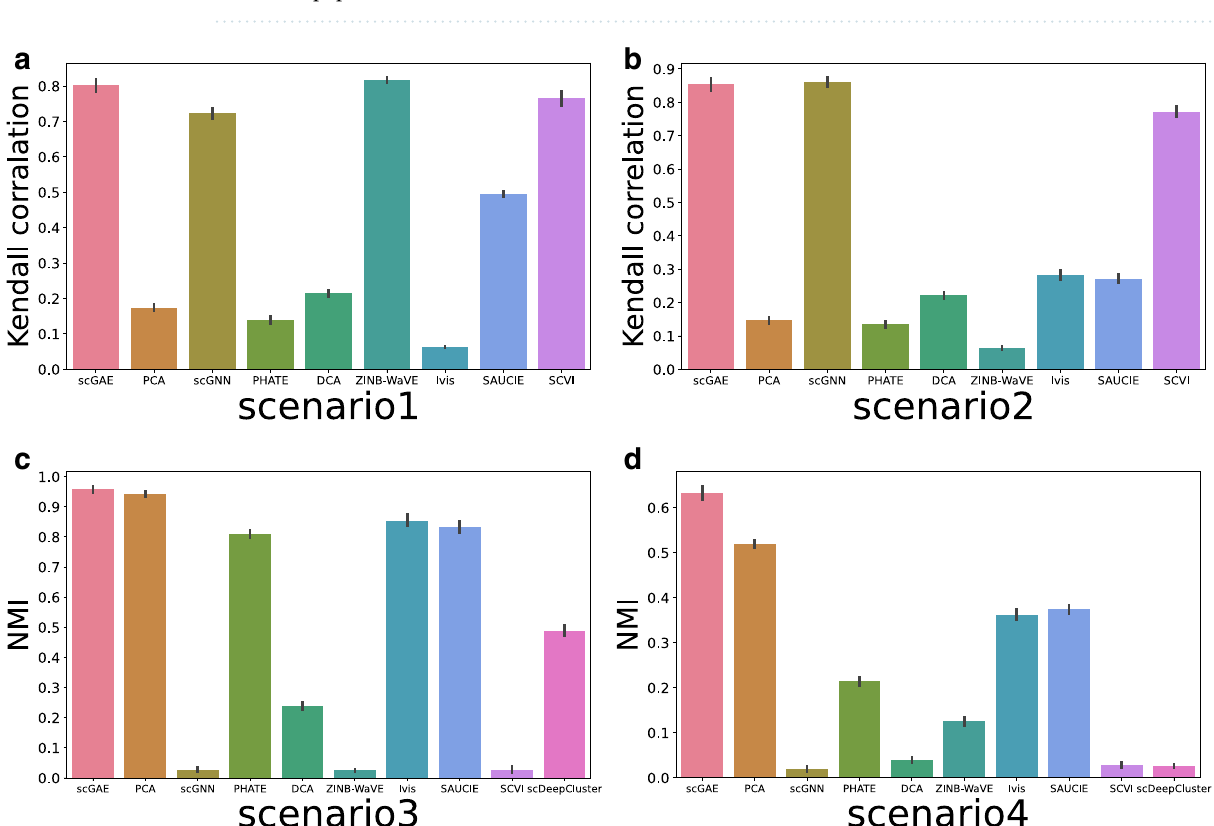
Figure 3. Quantitative evaluation of scGAE and several other competitive methods on clustering and trajectory inference tasks. In scenario1 ( a ) and scenario2 ( b ), the Kendall correlation between the ground truth and inferred trajectory was calculated. In scenario3 ( c ) and scenario4 ( d ), the normalized mutual information (NMI) measures the difference between the ground truth and the inferred